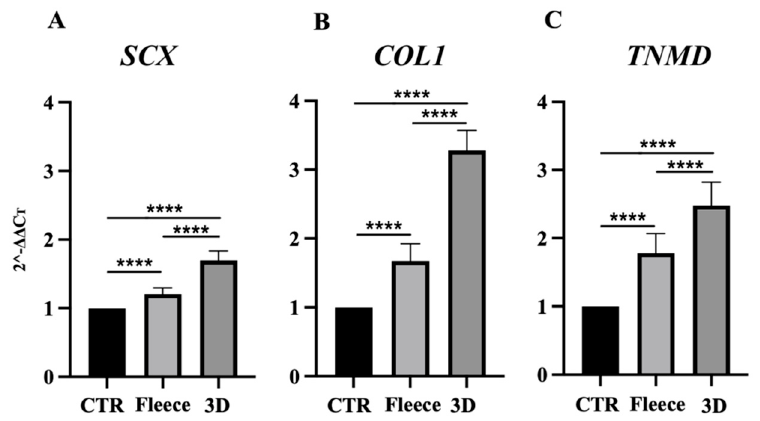
Figure 5. Tendon gene expression profile in AECs seeded on PLGA fleeces and 3D scaffolds. ( A ) SCX , ( B ) COL1 , and ( C ) TNMD gene expression after 48 h of culture. AECs on Petri dishes were used as the CTR (AECs at 48 h = 1). **** Statistically significant values between the different studied groups ( p < 0.0001).